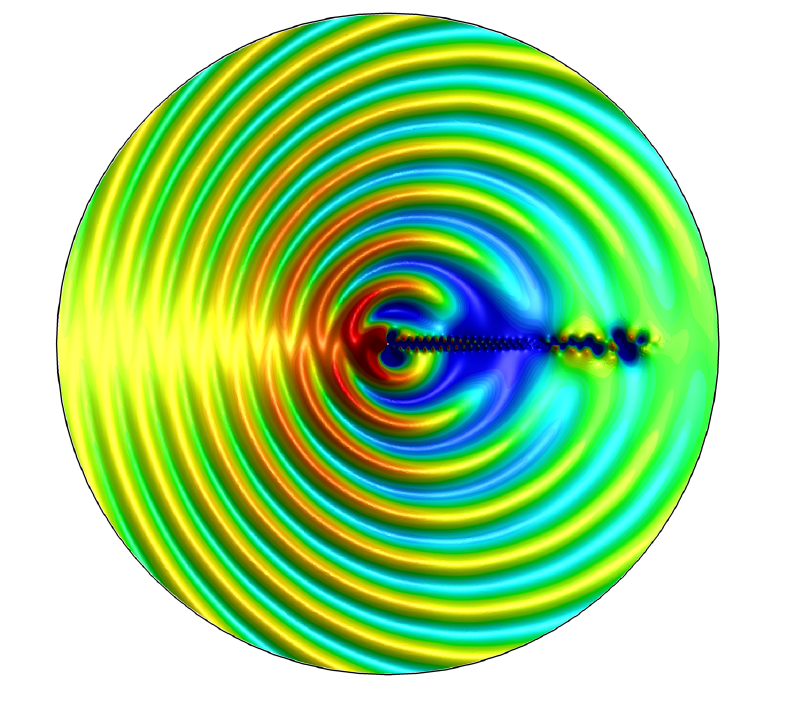
Figure 18. Sound field generated by the weakly compressible flow around a circular cylinder at time t = 900.